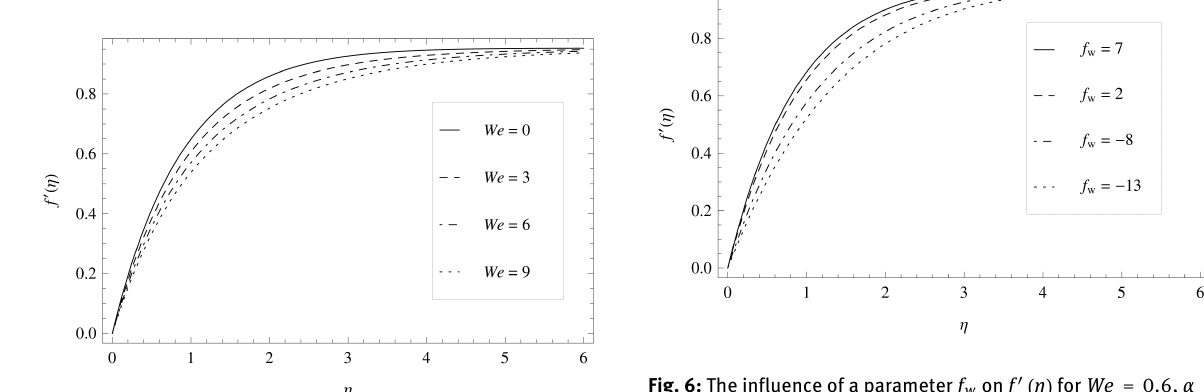
Fig. 6: The influence of a parameter f w on f (cid:48) ( η ) for We = 0.6, α = 0.1, M = 0.1, λ = 0.1 and (cid:126) =